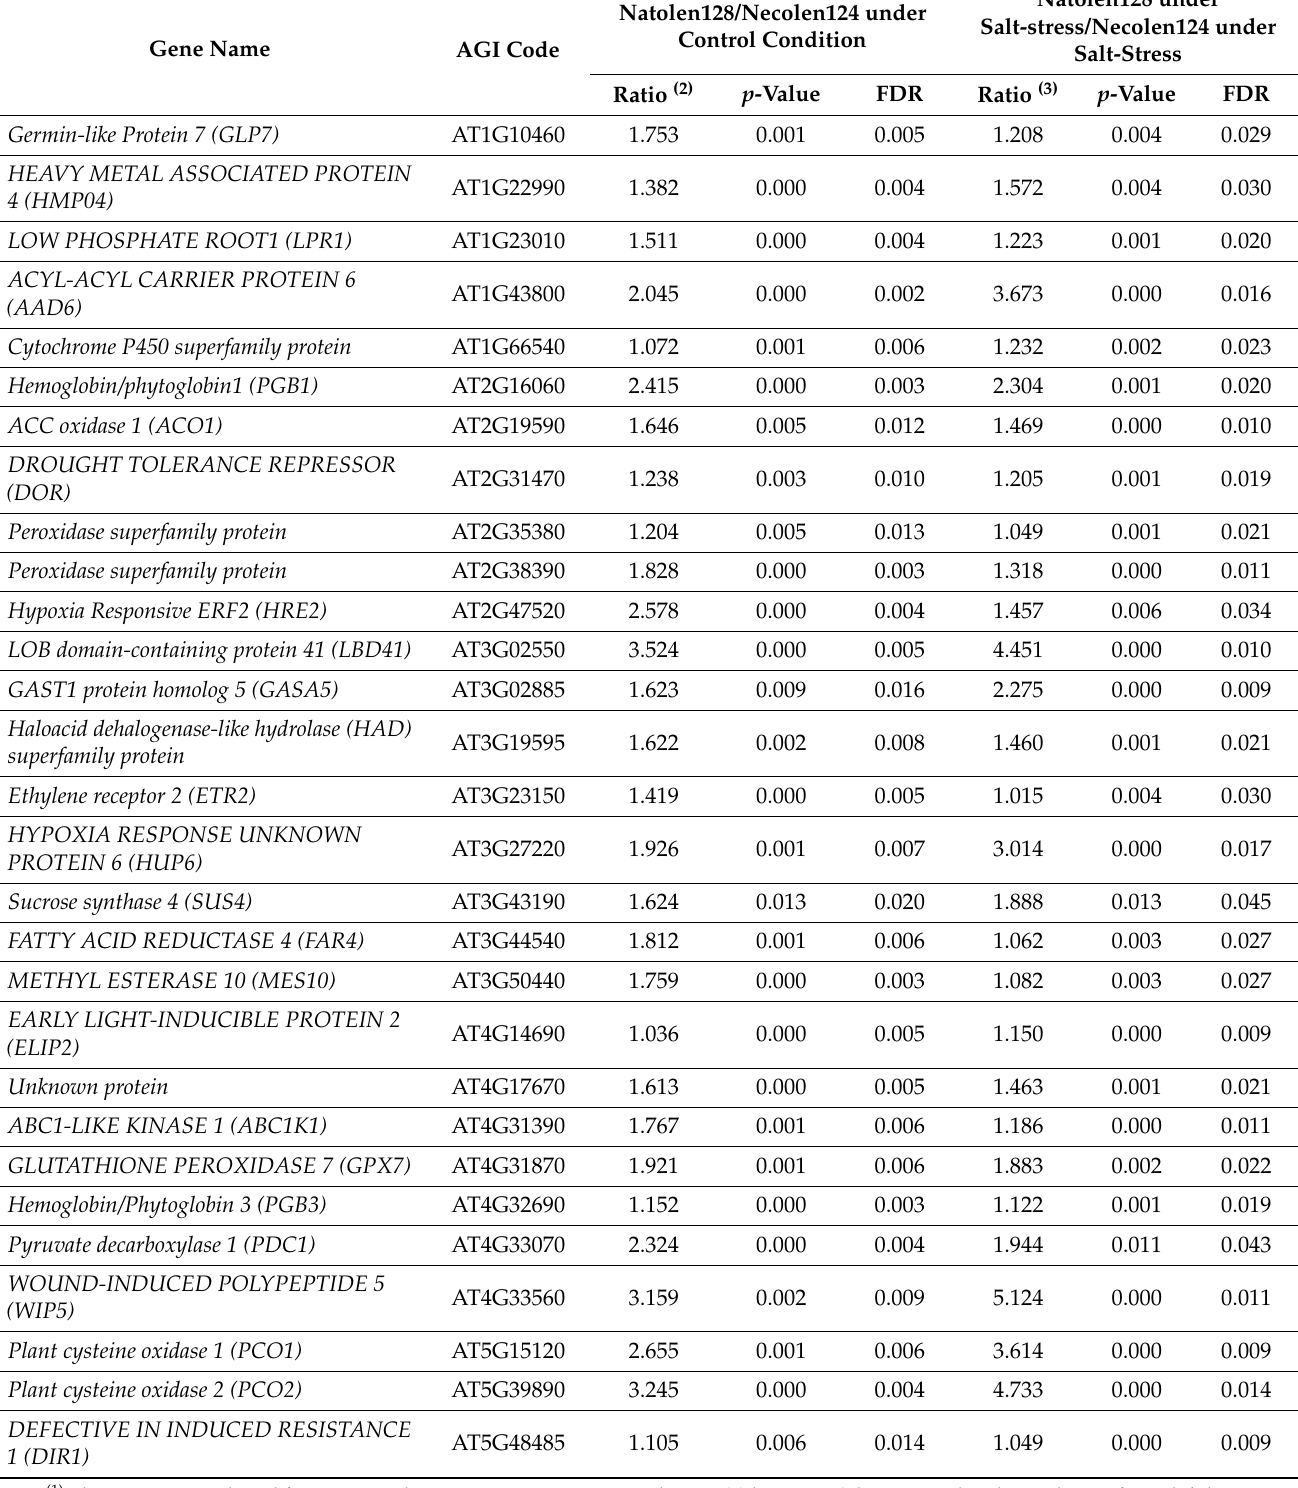
Table 1. List of Natolen128-upregulated genes classified as stress responsive (1)